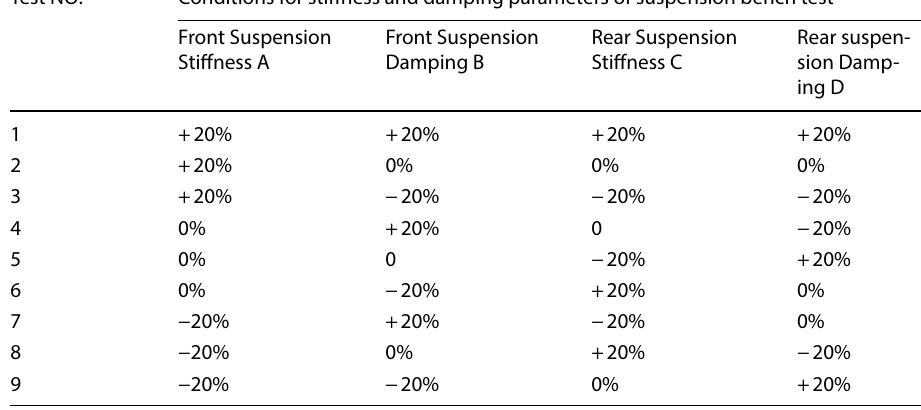
Test NO: Conditions for stiffness and damping parameters of suspension bench